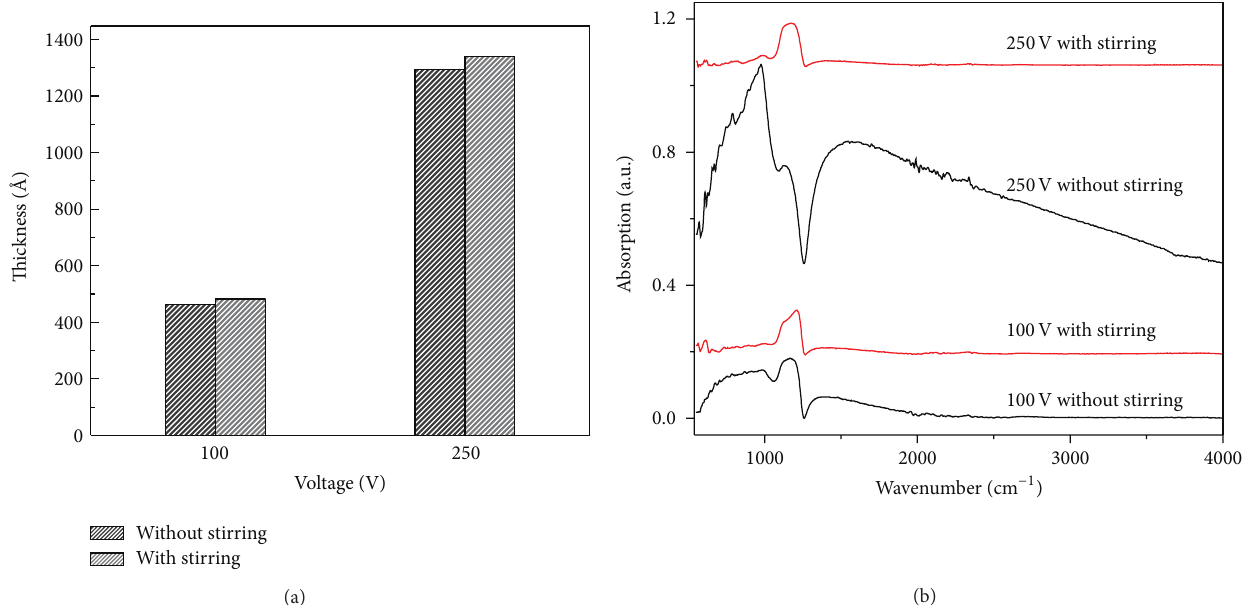
Figure 5: Effect of the mechanical stirring of electrolyte on (a) thickness and (b) chemical structure of oxide films deposited at 100 and 250 V.